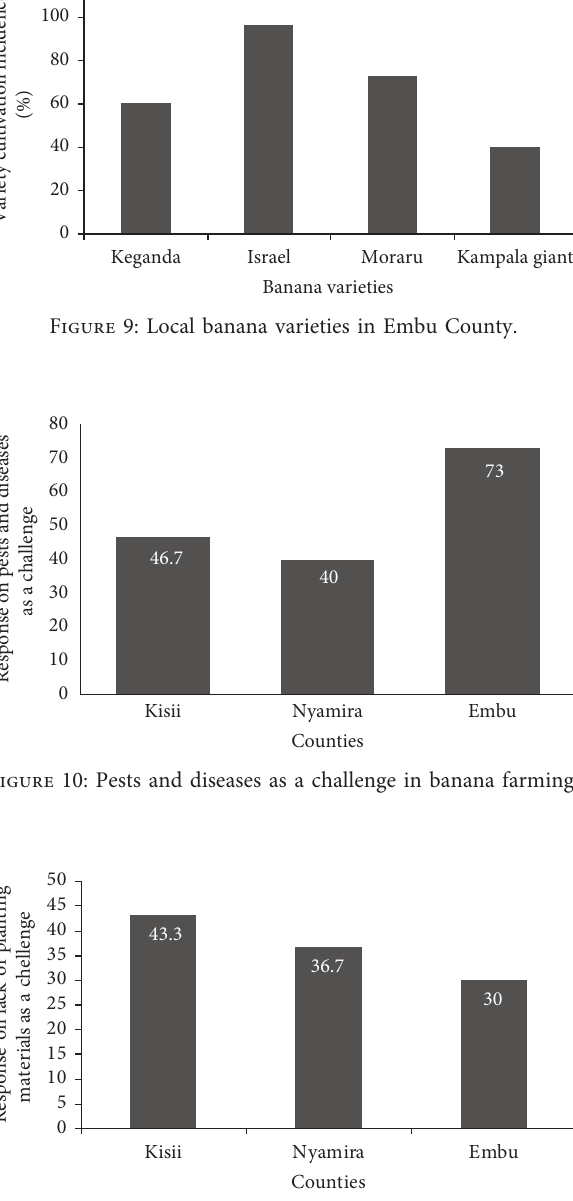
Figure 11: Lack of planting materials as a challenge in banana farming.